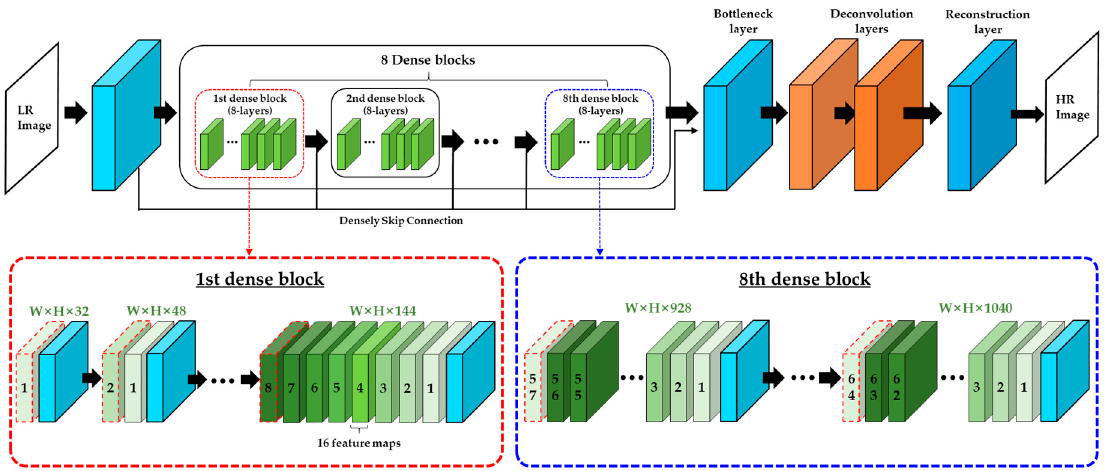
Figure 1. The framework of SR-DenseNet [18].